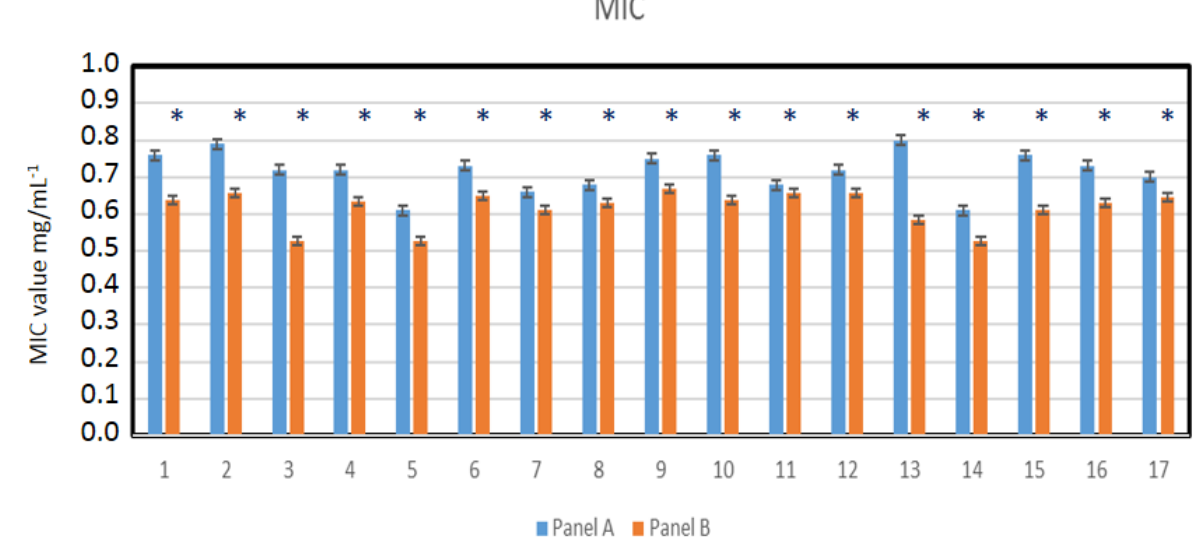
Figure 9. Virus particle analysis using MIC test (panel A: healthy volunteers without SARS-CoV-2) and (panel B: healthy volunteers after treatment of Salistat SGL03). Statistical significance vs. control in all analyzed samples were at * p < 0.05. X-axis number of study participants from 1 to 17.